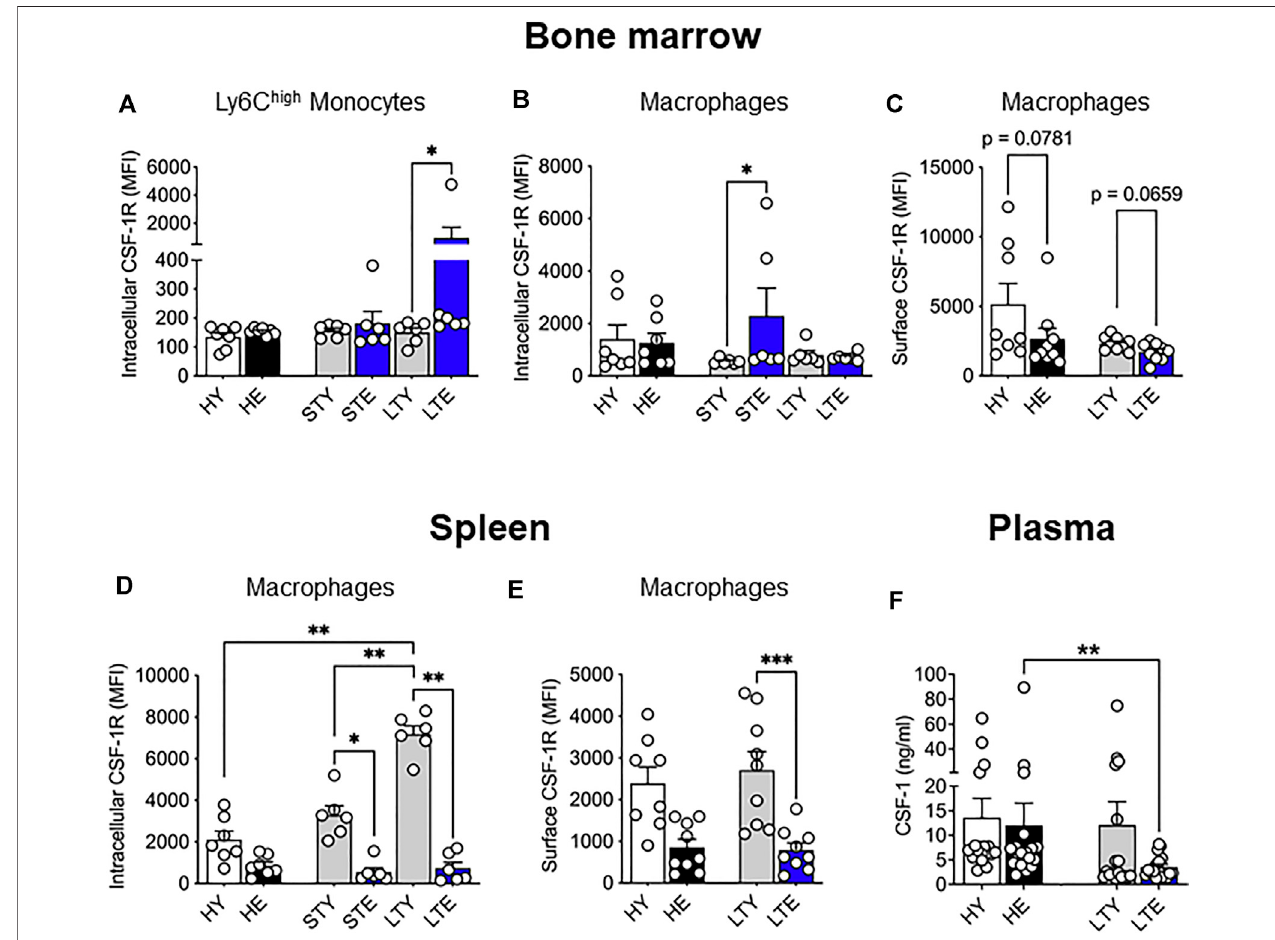
FIGURE4| BonemarrowandsplenicmonocyteandmacrophageCSF-1Rexpressionisdifferentiallyimpactedbyagingandcancer.YoungandelderlyC57BL/6J micewere inoculated with AE17 mesothelioma cells and sacri fi ced when tumors wereat small (early time point, tumor size < 30 mm 2 ) or large (late time point, tumor size 65 – 140 mm 2 ). Bone marrow Ly6C high monocyte (CD11b + F4/80 neg Ly6G neg Ly6C high ) (A) and macrophage (CD11b + F4/80 + Ly6G neg ) intracellular (B) and surface (C) CSF-1R expression shown as median fl uorescence intensity (MFI). Splenic macrophage intracellular (D) and cell surface (E) CSF-1R expression shown as MFI. Data on healthy mice ( Figure 1 ) have been included here as controls. Expression shown as median fl uorescence intensity (MFI). Circulating CSF-1 levels in plasma samples shown in (F) . HY, healthy young; HE, healthy elderly; STY, small tumor young; STE, small tumor elderly; LTY, large tumor young; LTE, large tumor elderly. Data shown as mean ± SEM; n = 6 – 8 mice/group for (A – E) and 17 – 19 mice/group for (F) ; * p < 0.05, ** p < 0.01, *** p < 0.005.